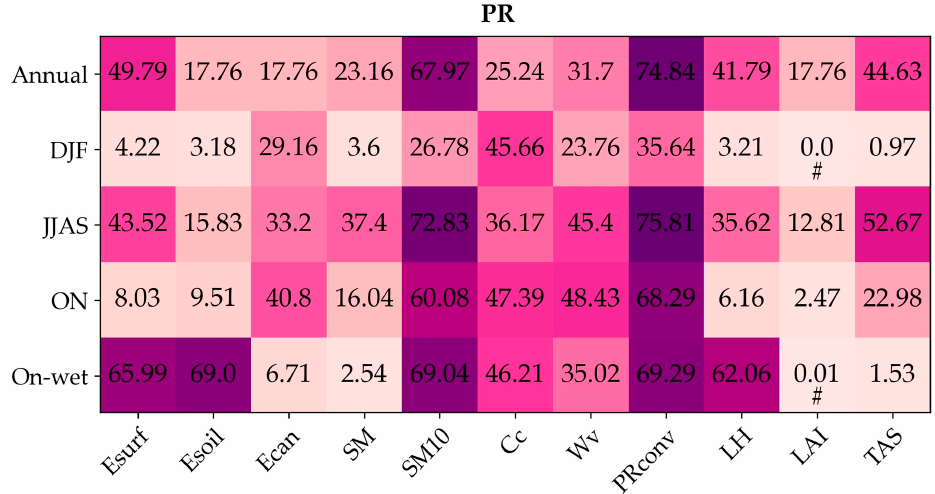
Figure 10. Changes in PR (%) based on averages over the robust grid cell at mm/year for the respective seasons and models. The shades of green indicate wet means (differences above zero) and the shades of brown denote dry means (differences below zero). The darker the shade the bigger the difference.